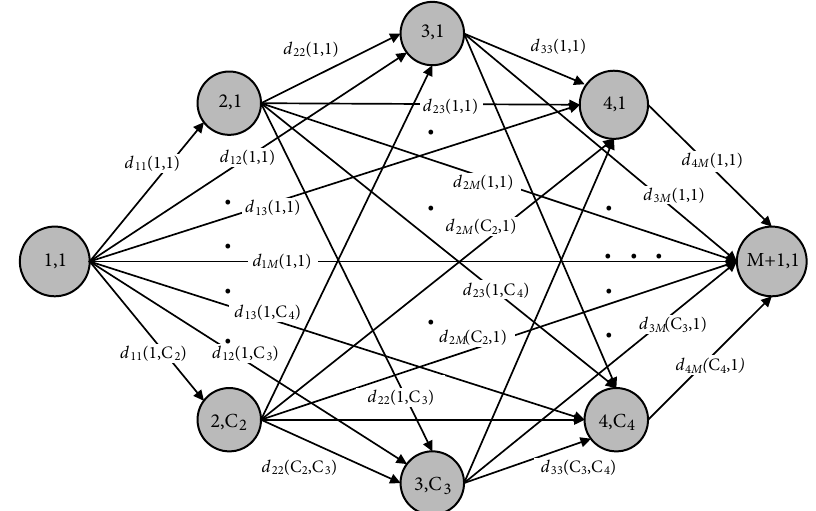
Fig. 6. The CEP problem can be seen as the shortest path problem for an acyclic network in which the nodes represent all possible values of capacity points (the links connecting neighbour airports on the route are representing CES